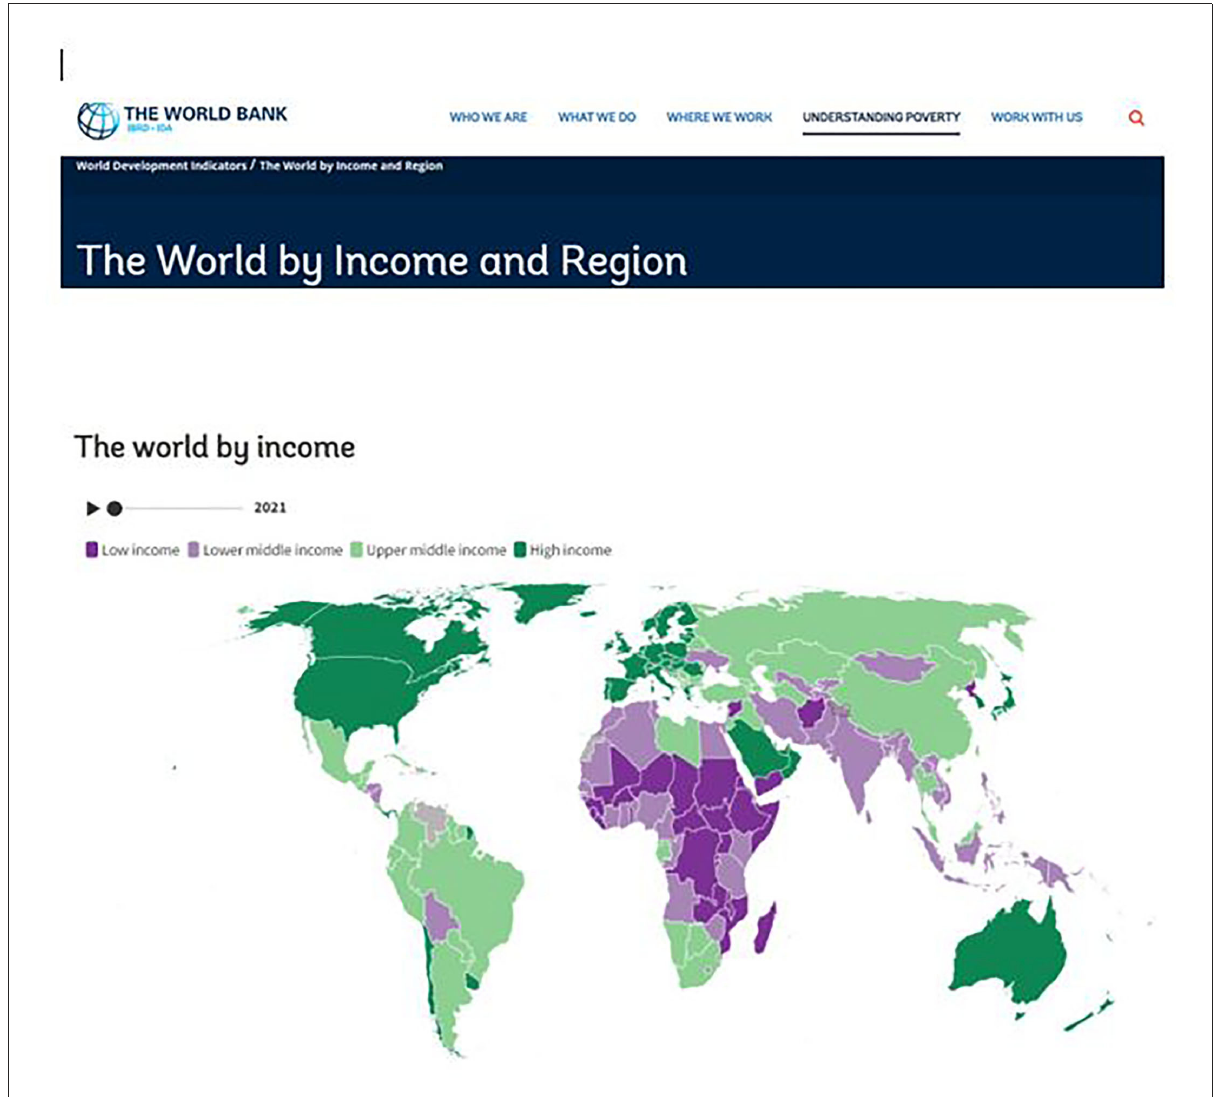
FIGURE1 World by income (source: The World